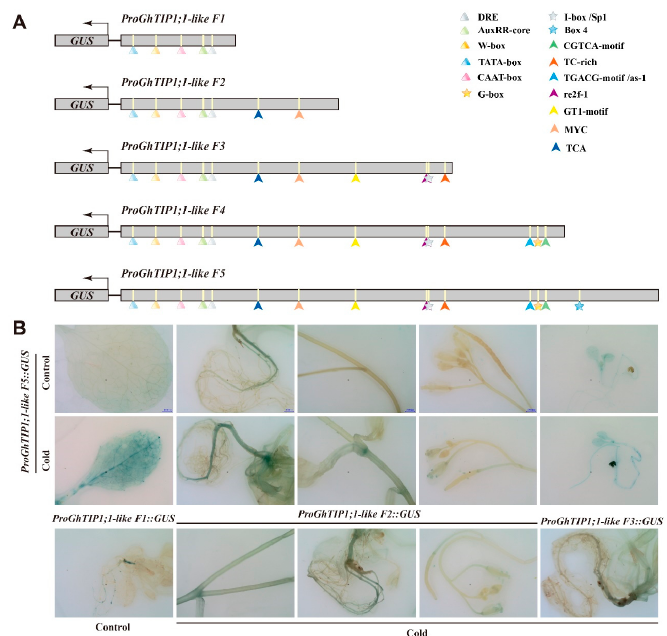
Figure 11. Promoter deletion analysis of GhTIP1;1-like under different temperature conditions. ( A ) Schematic representation of ProGhTIP1;1-like::GUS constructs. Different symbols indicate different motifs of interest. ( B ) Histochemical GUS staining of transgenic Arabidopsis with ProGhTIP1;1-like F5 , ProGhTIP1;1-like F3 , ProGhTIP1;1-like F2 , and ProGhTIP1;1-like F1 under normal-temperature (22 °C) and cold conditions (4 °C).